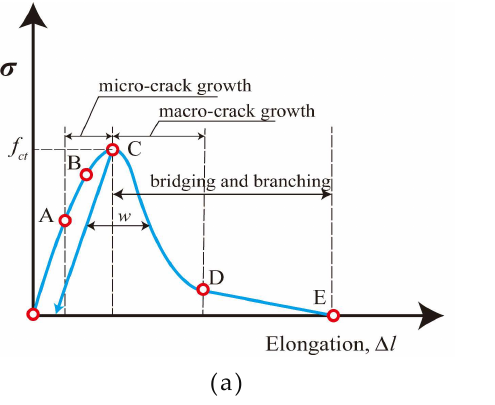
Figure 2. Schematic of the crack development process: ( a ) Stress-elongation curve of concrete; ( b ) fracture propagation